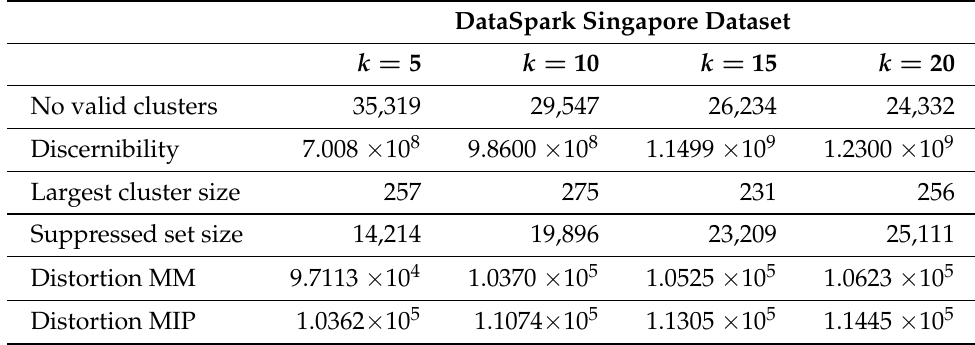
Table 1. Study of discernibility and distortion with a varying k on the DataSpark Singapore dataset.